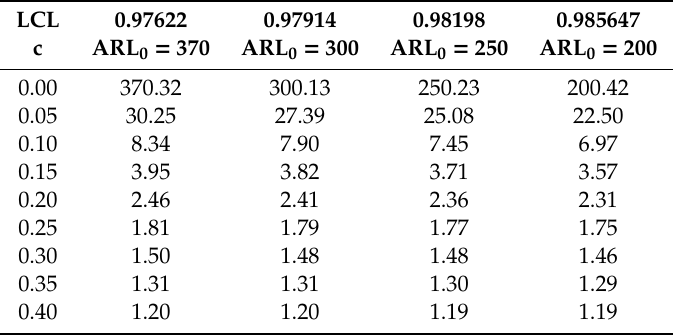
The ARLs for the proposed chart when n = 25, LND (0.45,1.50), USL = 74.7197, and LSL = 0.0329.